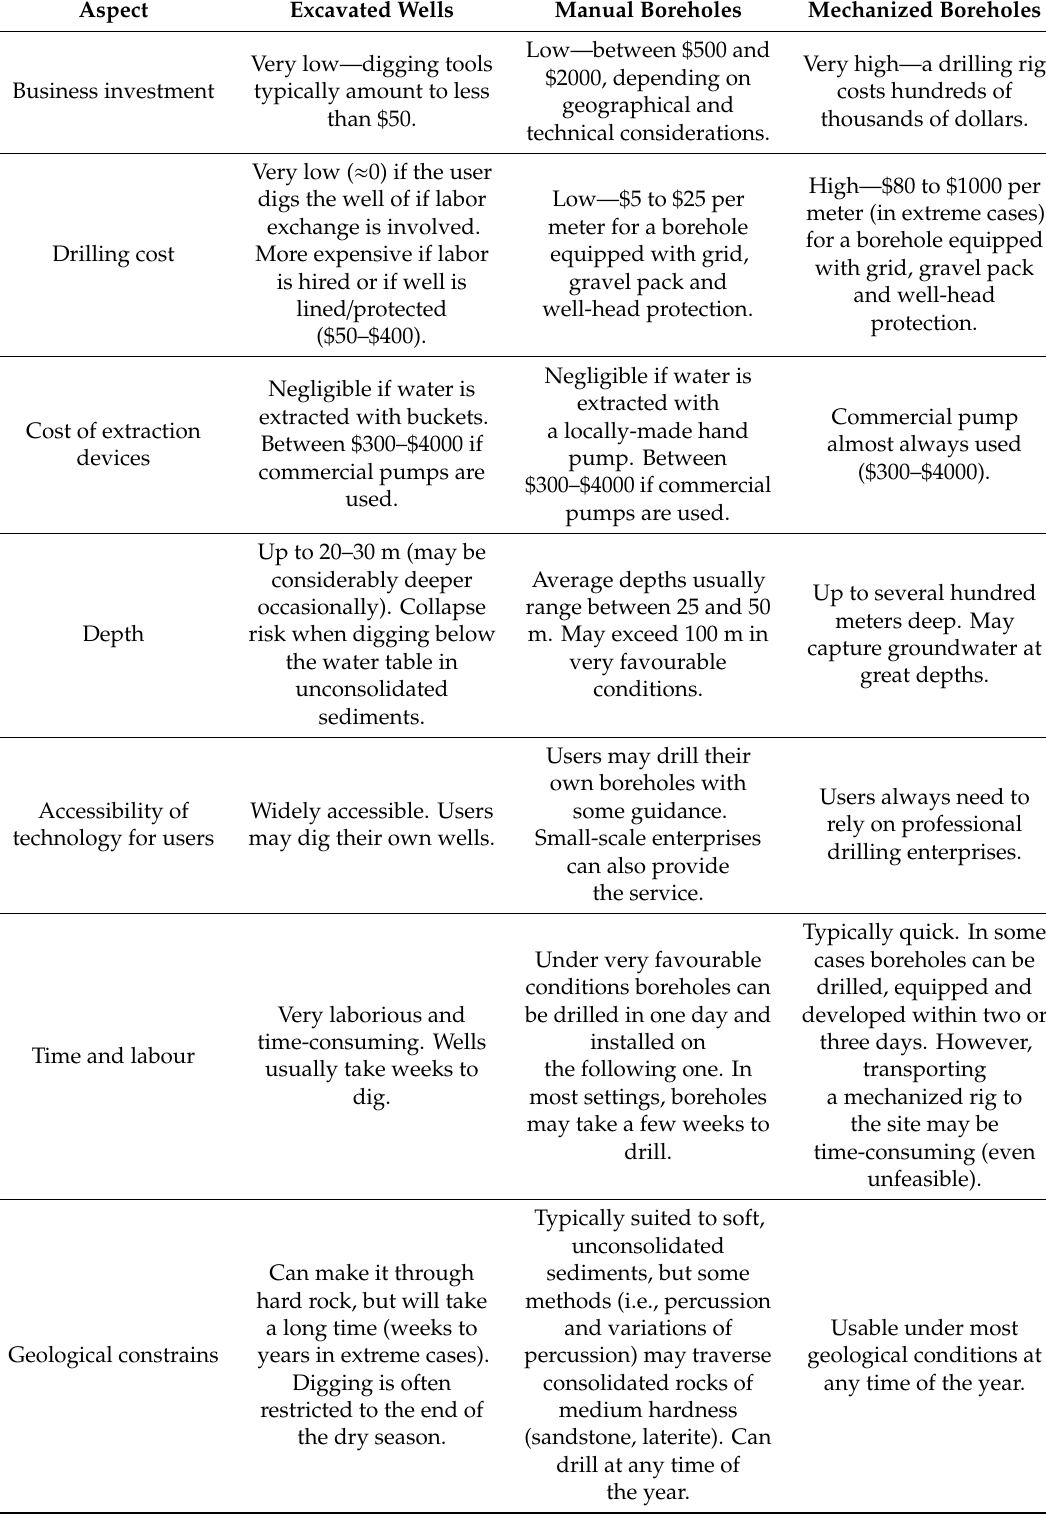
Table 4. Comparison between excavated wells, manual boreholes and mechanical well drilling (partially based on comparative frameworks from the manual drilling literature